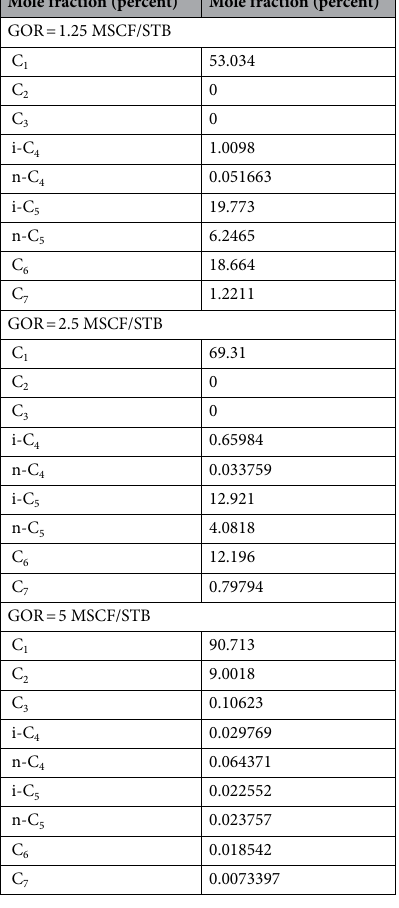
Table 3. The composition of rich gas with